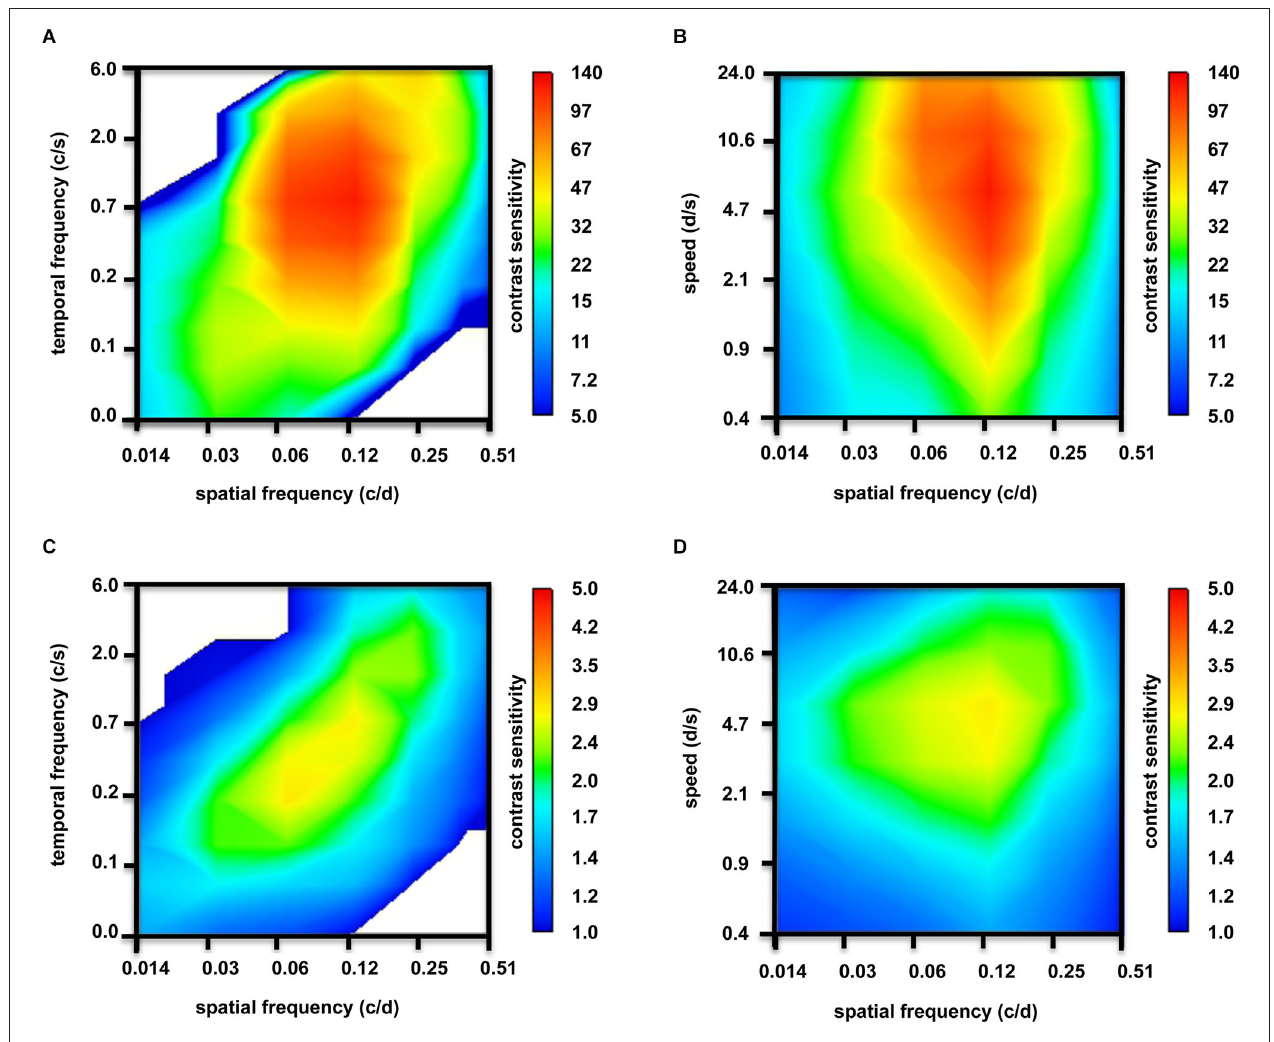
observed at photopic light levels. (C) At scotopic light levels, the tuning to spatial frequencies was weaker. Again, there was no temporal frequencies tuning. (D) However, clear tuning to speed was observed at scotopic light